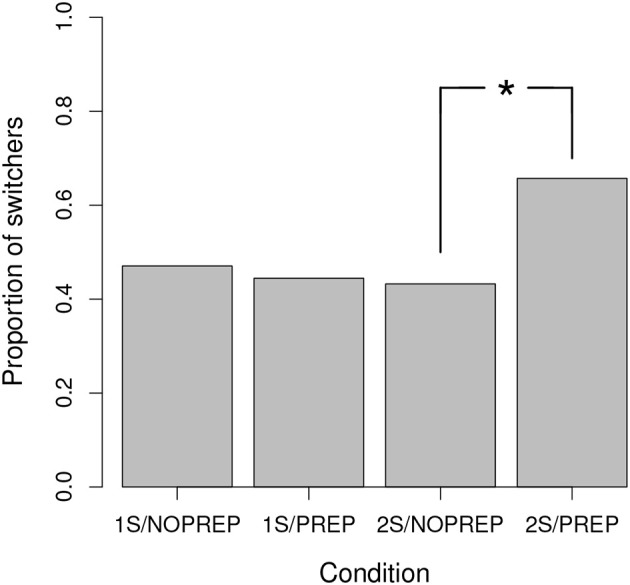
Proportion of switchers in each condition. *Denotes a proportion statistically significant (p < 0.05).